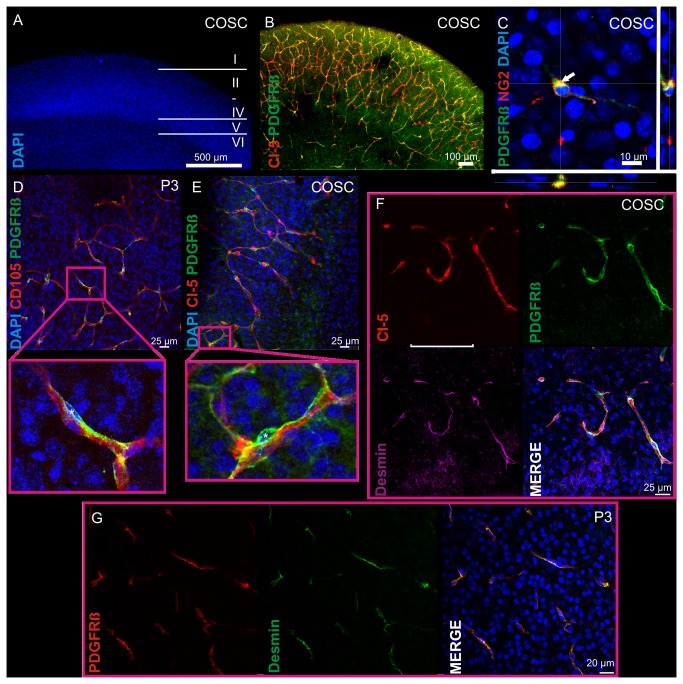
Pericytes in cortical organotypic slice cultures.Microvessels and pericytes in COSC were immunolabelled with different vascular markers (CD105, Cl-5), the pericyte marker PDGFR beta and DAPI. COSC preparations displayed a well preserved cytoarchitecture of cortical layers after 5 DIV (DAPI, epifluorescent image, A). A high number of microvessels covered by pericytes remained in COSC (epifluorescent image, B). PDGFR beta (green) partly co-localized (yellow) with the proteoglykan NG2 (red) in COSC which is another pericyte marker (arrowhead, confocal Z-stack with orthogonal section views, C). Similar to the perivascular localization of PDGFR beta positive cells in newborn mice at the age of postnatal day 3 (D) we observed PDGFR beta positive cells to be in close contact with microvessels in COSC after 5 DIV (E). Note the DAPI positive pericyte cell soma in which the nucleus is mostly spared by PDGFR beta staining (marked by asterisks) and its processes that follow the microvessel (D, E insets). Further the pericyte marker Desmin was found to be expressed by perivascular PDGFR beta positive cells in COSC (Panel F) as well as in native P3 mice (Panel G). Pericyte coverage in cortical microvessels was not significantly different in native P3 mice compared with COSC (H).